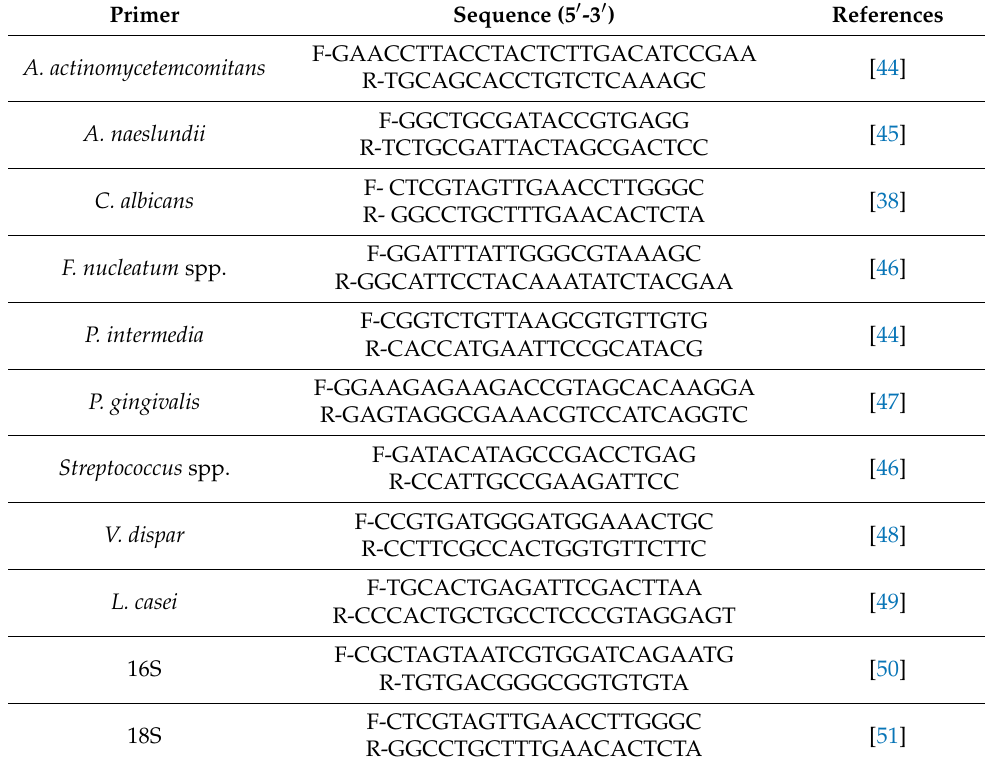
Table 1. Primers used in the study.